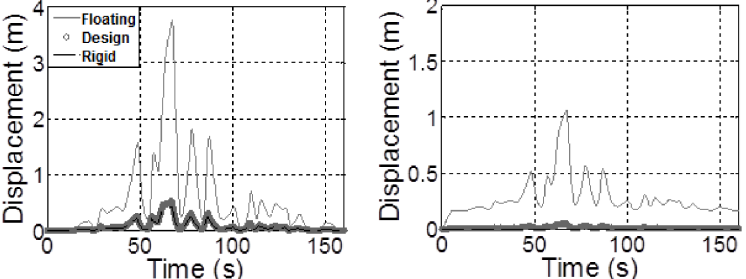
Fig. 9. Displacements in the direction normal to the TL at top (Node 19 – left) and bottom (Node 148 – right) of tower GTS 01, due to TS wind load, for three support types considered